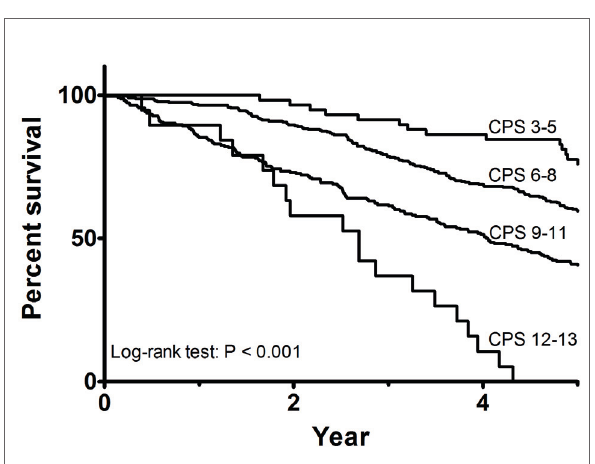
Fig. 1. Kaplan-Meier curve for all-cause death.